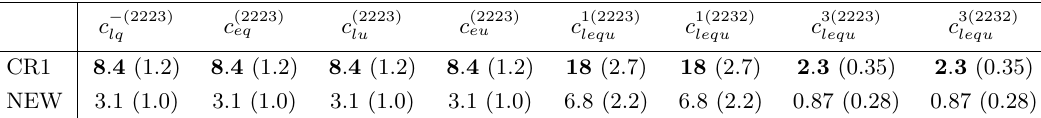
Table 2 . Bounds on c for (cid:3) = 1 TeV, asuming one operator at a time, using the di(cid:11)erent signal regions de(cid:12)ned in the text. The numbers without (within) parenthesis stand for the LHC13 (HL- LHC). The boldface indicates limits using actual data. These numbers can be obtained from the master equation (2.14) using the coe(cid:14)cients in table 1 and the upper bound on the following number of signal events: s CR1 = 143 (315) and s NEW = 18 (179), where again the number in max max brackets correspond to HL-LHC projections. The projected bounds on the coe(cid:14)cients get a factor of 3 weaker for systematic uncertainties of 10 (cid:24)